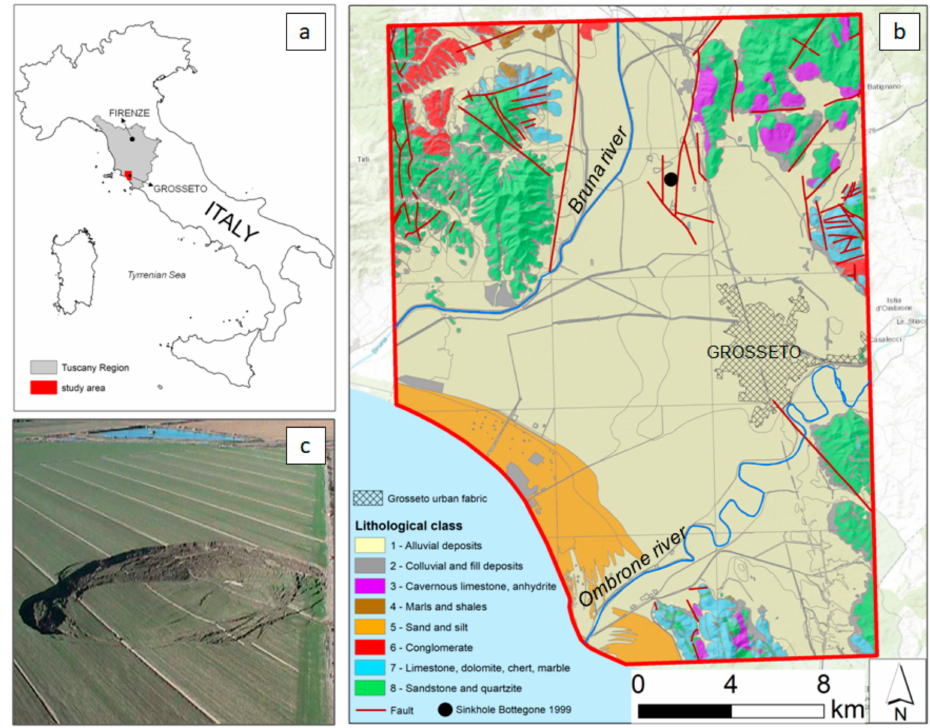
Figure 1. Overview of the study area: ( a ) location of the study area; ( b ) lithological setting of the study area, modified from [45]); ( c ) photo of the sinkhole event in Bottegone site in 1999, modified from